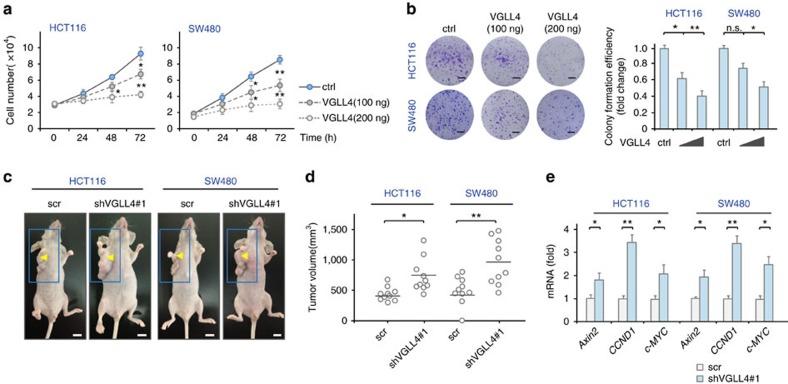
VGLL4 inhibits colorectal cancer cell growth.(a) VGLL4 inhibited proliferation of HCT116 cells and of SW480 cells. (b) VGLL4 inhibited colony formation of HCT116 and SW480 cells. Scale bar denotes 10 mm. (c,d) Knockdown of endogenous VGLL4 by shVGLL4#1 promoted xenograft tumour growth. Mice were photographed after being killed. Black bar denotes the mean value from one experiment. Scale bar denotes 10 mm. (c) Tumours harvested from each mouse were photographed before further processing. (d) The tumour volumes were measured for the mice from each group (ten mice). (e) mRNA levels of Wnt target genes in samples from panel d. Note: Data in a,b,d and e were from one experiment. Experiments we repeated two times. Unpaired t tests were used to compare the difference between groups. *P<0.05, **P<0.01, significant relative to control. n.s., no statistics significance.